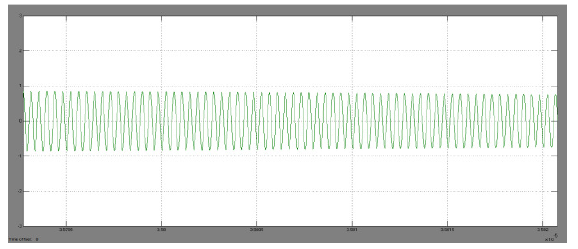
Fig. 21. Transmitted Signal of Proposed Zigbee